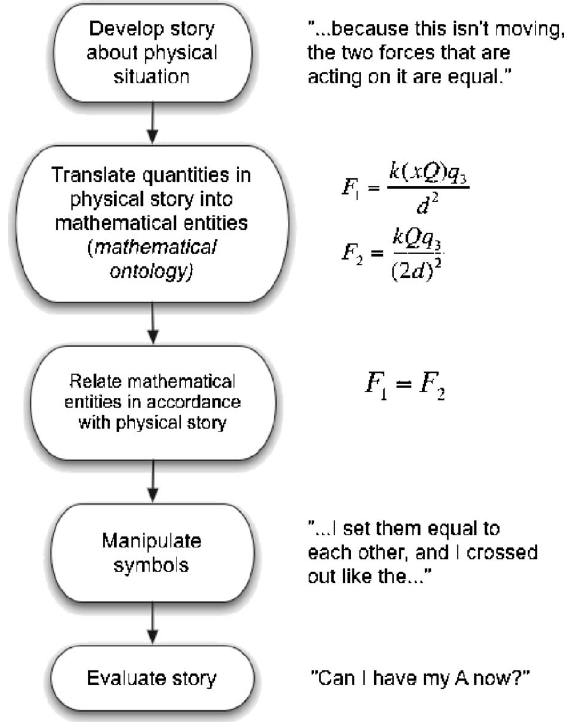
FIG. 9. Schematic map of Alisa’s moves within Mapping Mean- ing to